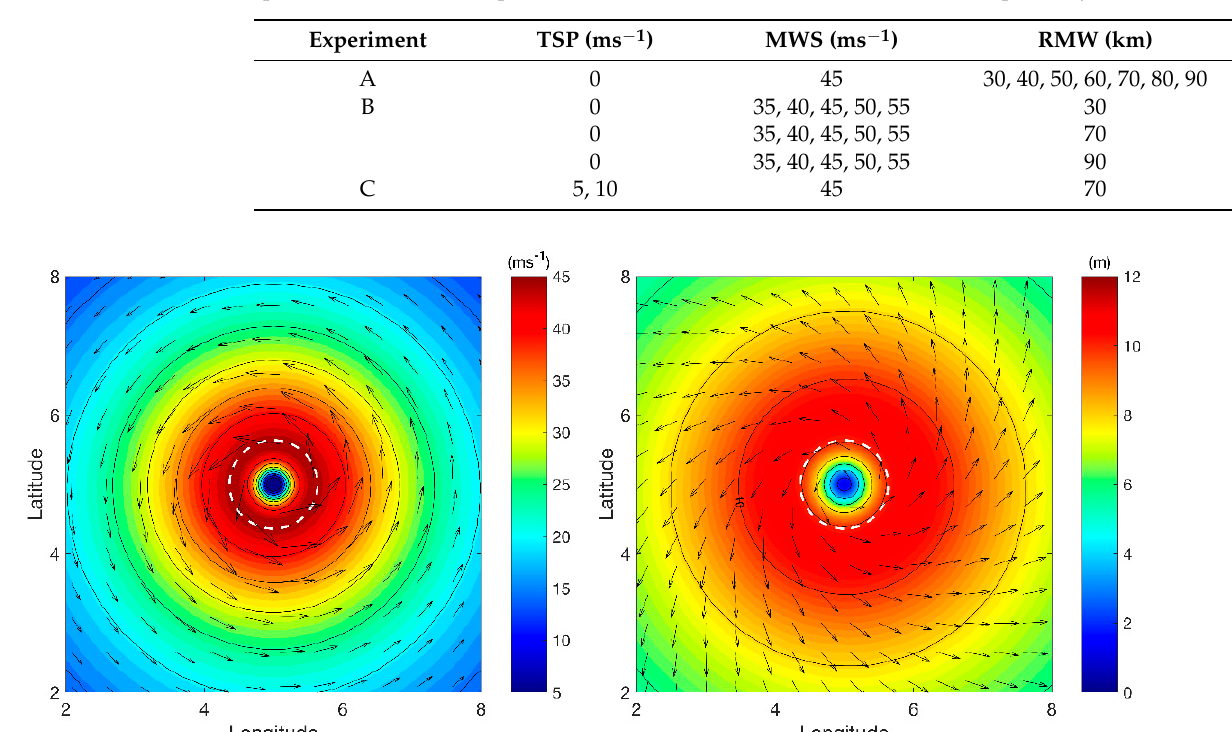
Table 1. Experimental designs of the TC experiments. Here, TSP, MWS, and RMW denote translation speed, maximum wind speed, and radius of maximum winds of the TC, respectively.